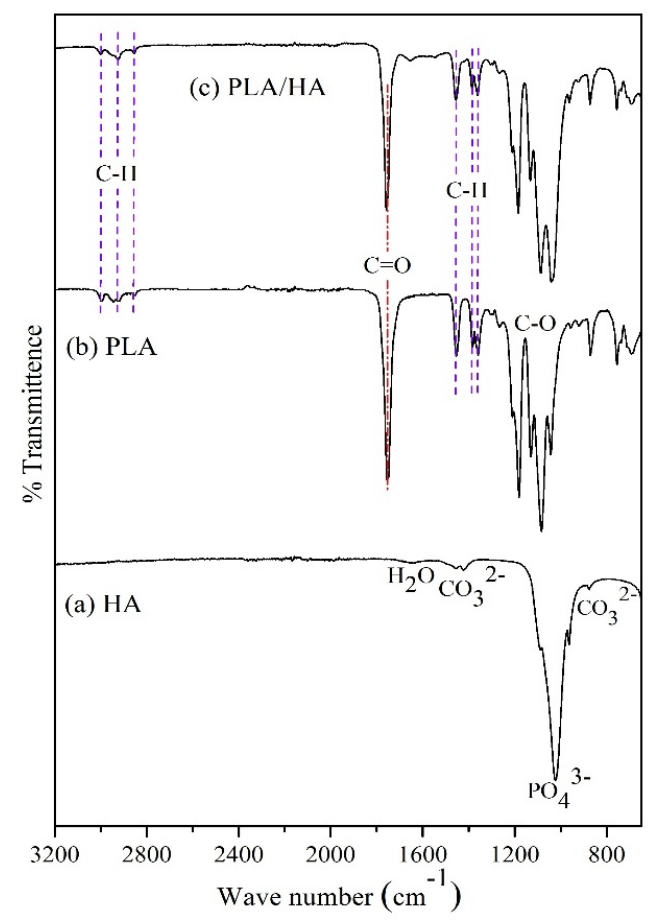
Figure 3. FT-IR spectrogram of ( a ) HA, ( b ) PLA, and ( c ) PLA/HA 15%.